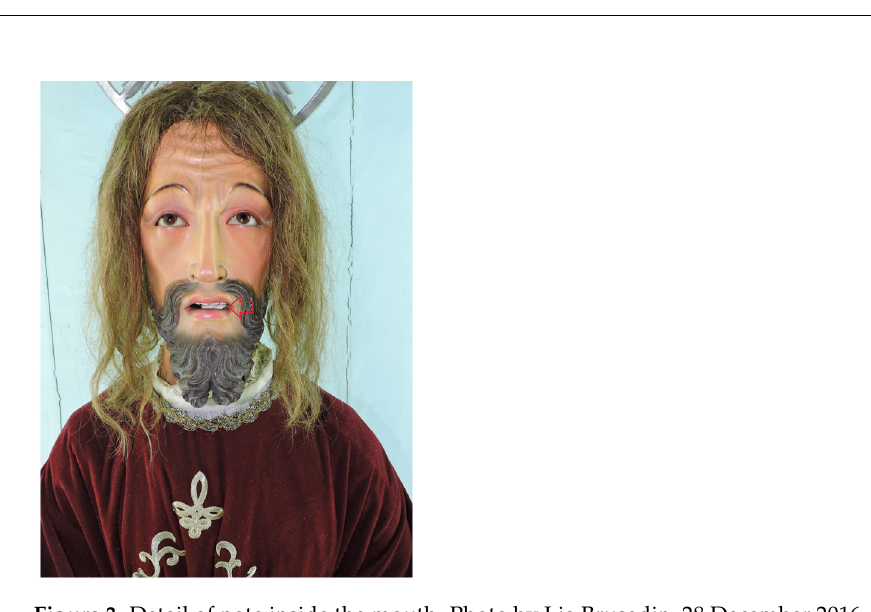
Figure 3. Detail of note inside the mouth. Photo by Lia Brusadin, 28 December 2016.